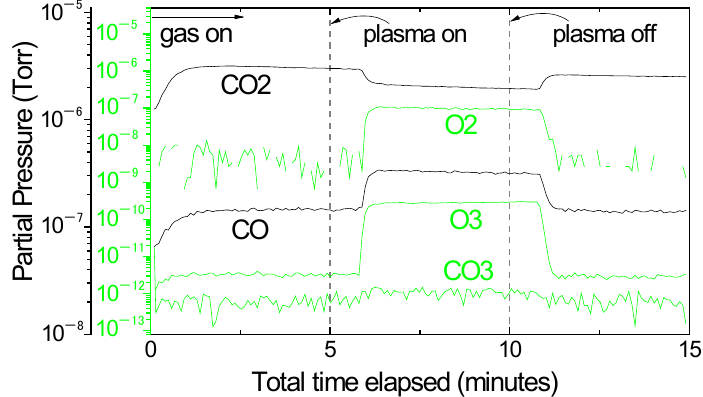
Figure 3. Online monitoring data of CO 2 PAG byproducts using QMS.